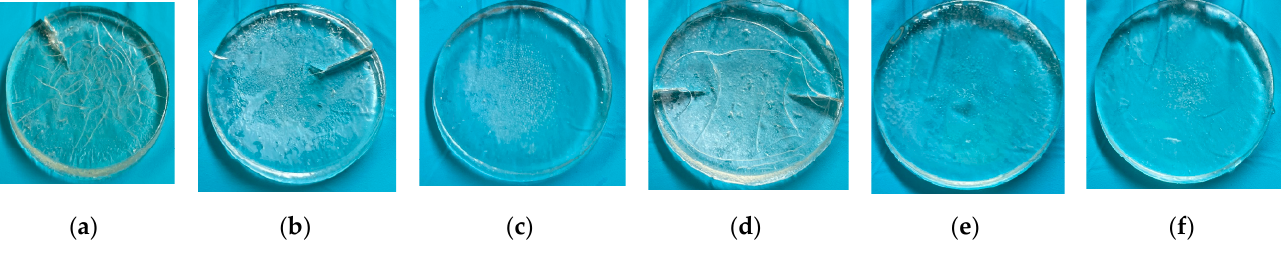
Figure 8. Swollen gels at equilibrium at room temperature: ( a ) FC32; ( b ) FC33; ( c ) FC34; ( d ) FC35; ( e ) FC36; and ( f ) FC37. Figure 9. Swelling ratio (%) of formulations FC32–FC37